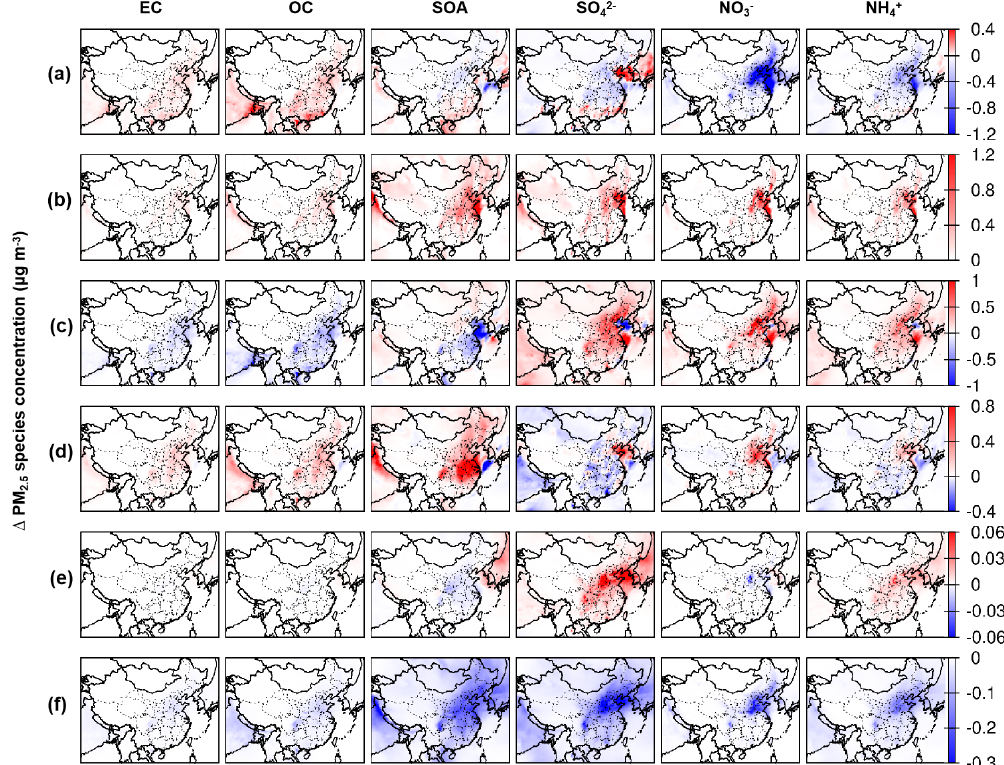
Figure 6. Changes in monthly average PM 2 . 5 component concentration (µgm − 3 ) in July due to (a) T + 1 . 0K, (b) WS − 10%, (c) AH + 10%, (d) PBLH − 20%, (e) CLW + 10%, and (f) PCP +